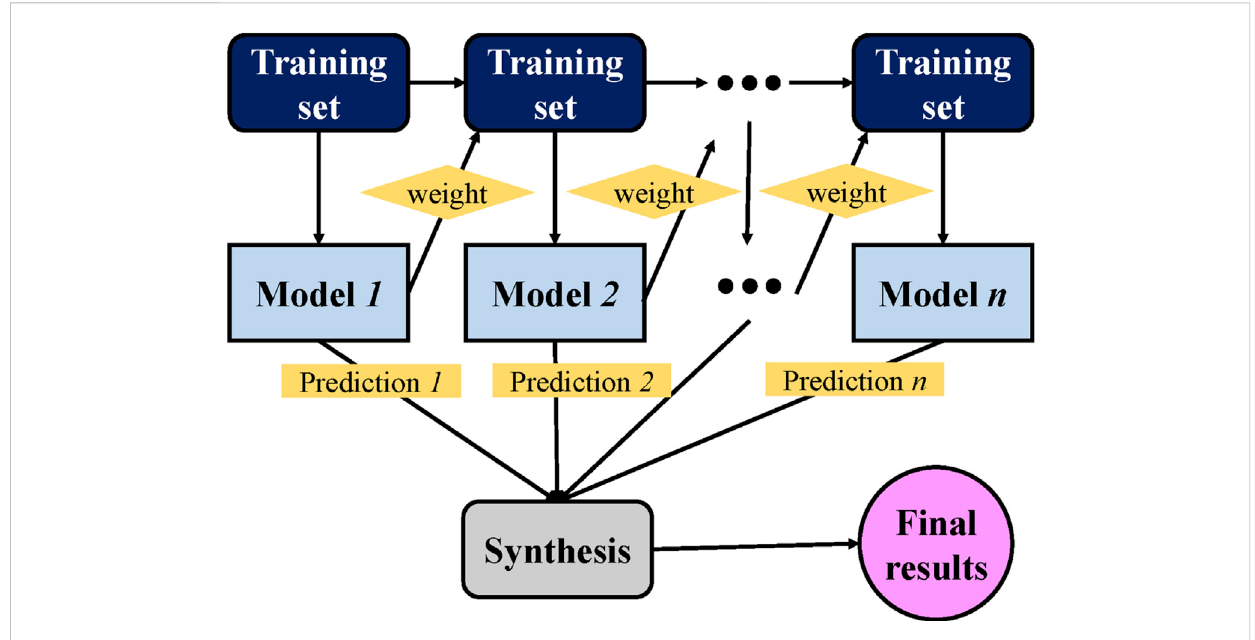
FIGURE 3 Structure of the Adaboost algorithm (Wang et al.,